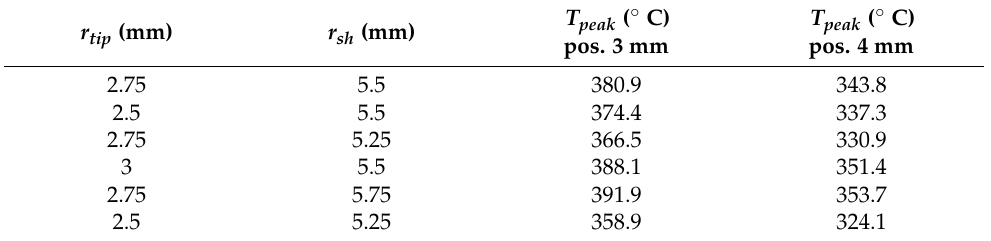
Table A3. Analysis of the sensitivity of the model outputs to variations in the pin